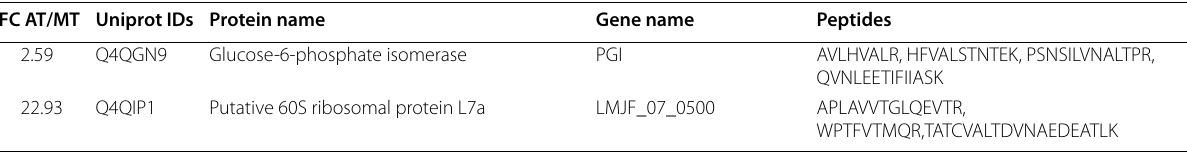
The PPI network of the significant differentially expressed proteins (between metacyclic and amastig- ote like stages of L. tropica ) was constructed, in which including 53 nodes and 323 edges (Fig. 4a). Nodes represent the proteins from our list and others that directly interact with them. Connections contain direct interaction partners and interconnections. In order to simplify the connection patterns, interactions for the nodes with the greatest degrees (hubs) was selected.